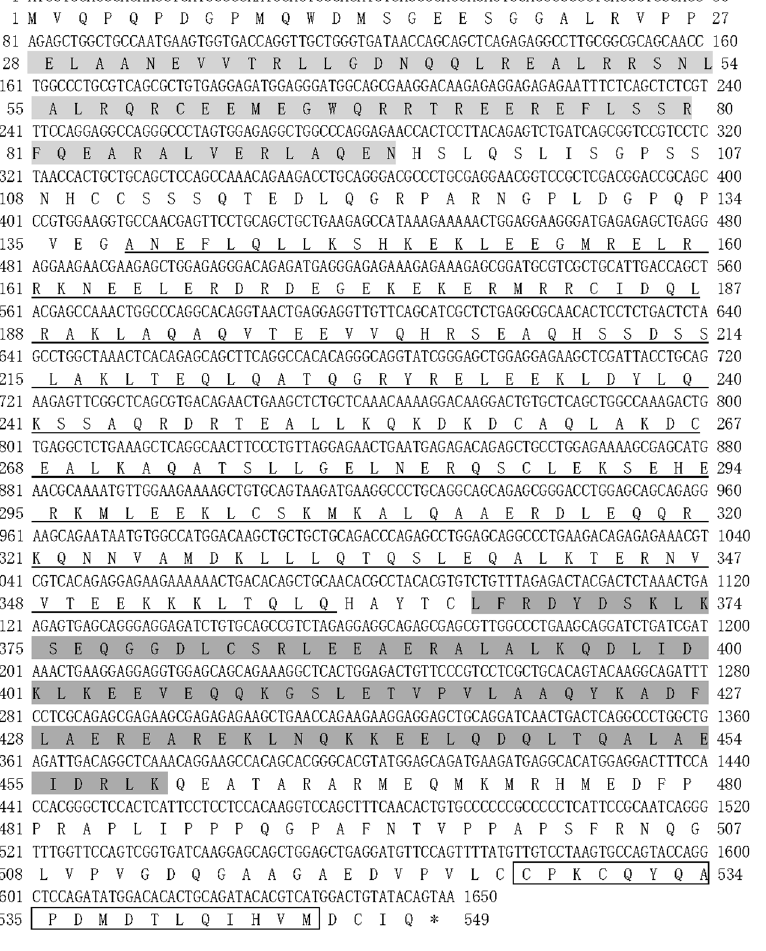
Figure 4. NEMO ORF sequence and predicted amino acid sequence analysis. NEMO domain is marked by light grey shadows. The low-complexity region is underlined. The CC2-LZ (coiled coil region–leucine zipper) domain is marked by dark grey shadows. The ZnF C2H2 (Zinc finger) domain is marked by a box. * stands for termination